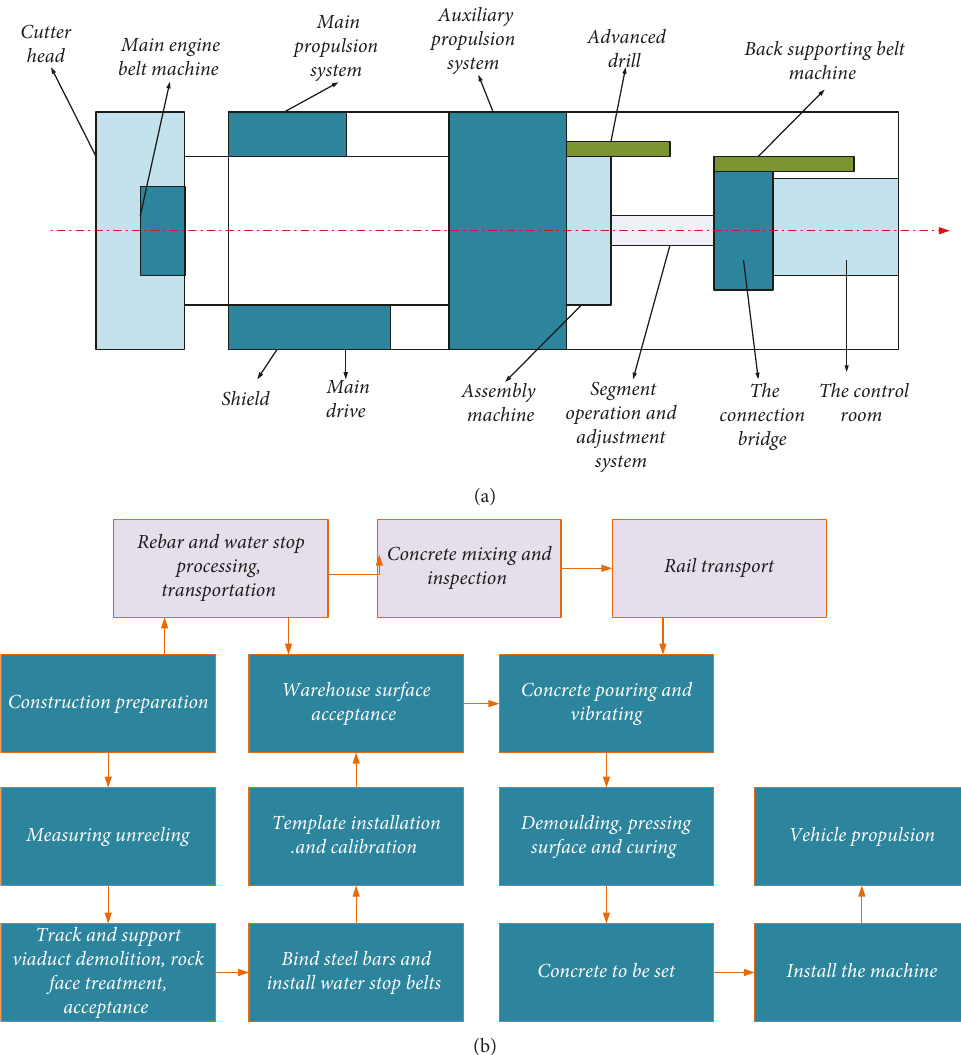
Figure 2: Shield mechanism type and working procedure diagram. (a) Shield machine structure diagram. (b) Shield machine working procedure diagram.